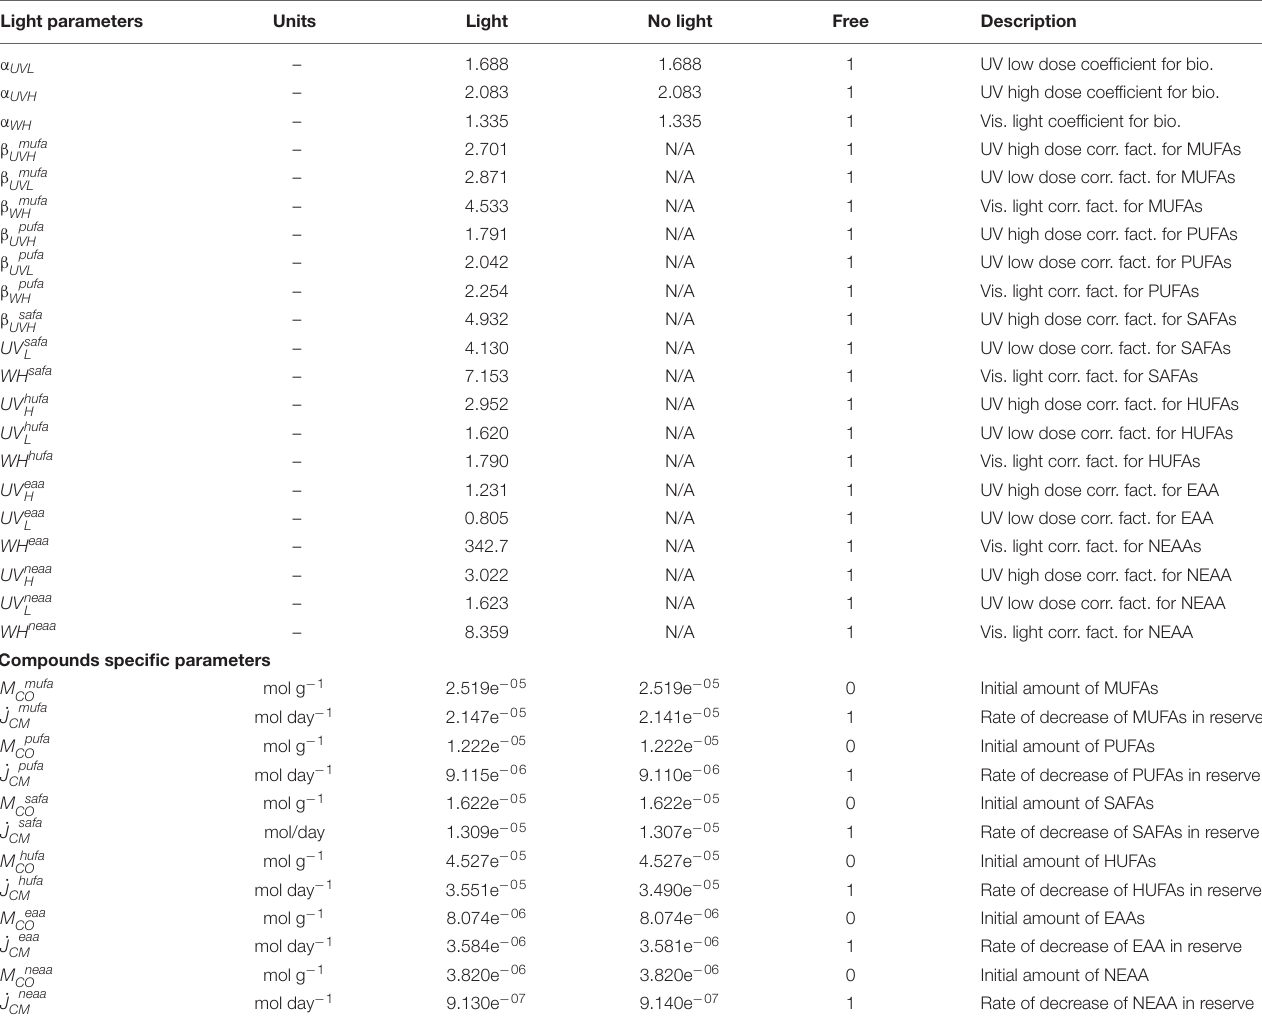
TABLE 2 | Light and compounds specific parameters.